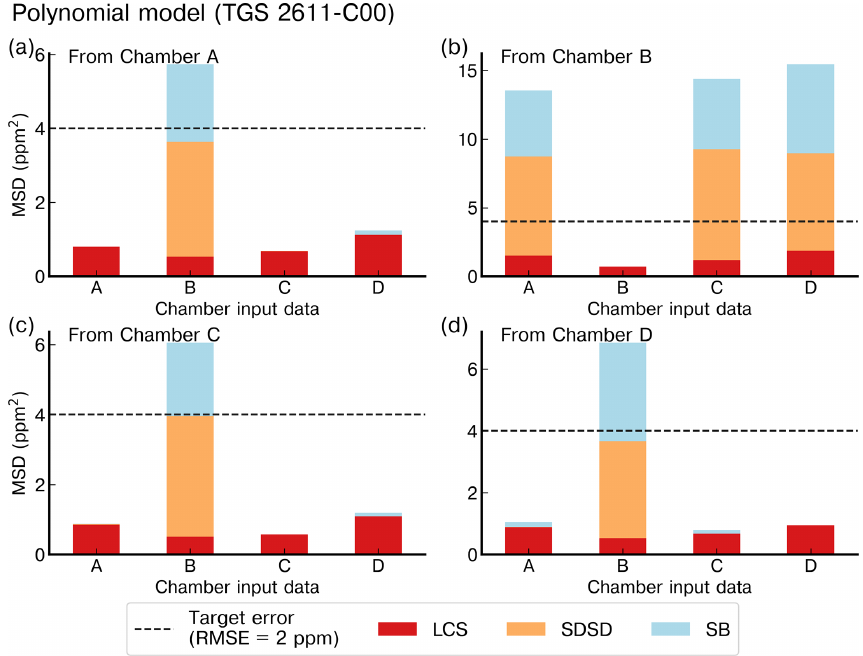
Figure 10. Reconstruction error of the peaks for the polynomial model with TGS 2611-C00 as input using the best stratified training case from (a) chamber A, (b) chamber B, (c) chamber C and (d) chamber D to reconstruct the peaks from the other chambers (listed on the x axis) with data from the same type of sensor. Note the different ranges of the y axis for the panels (b) and (c) .